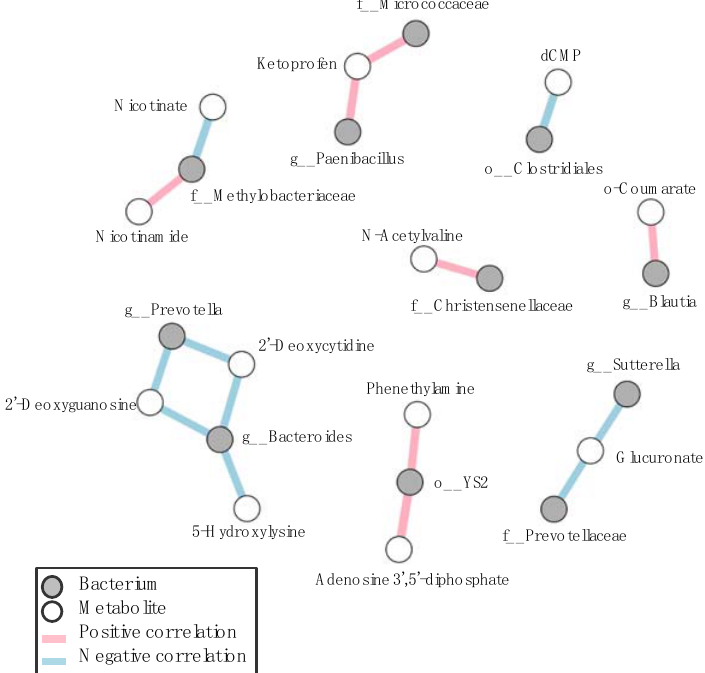
Figure 4. Correlation networks between gastrointestinal microbes and metabolites in SPF mice. Correlation plots of pairwise correlations among gastrointestinal microbe-metabolite were calculated by Spearman’s rank correlation coefficient. Positive and negative correlations at the cut off level of the p value of 0.05 are shown as red and blue lines, respectively. Gray and white circles indicate gastrointestinal microbes and metabolites, respectively.